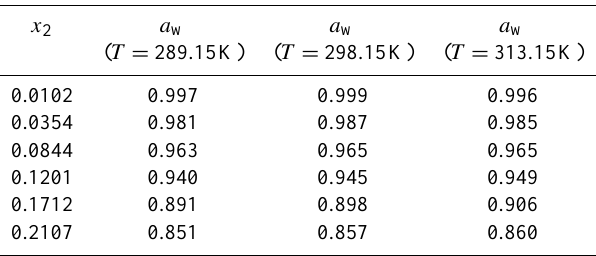
Table A6. Bulk water activity (a w ) measurements a of water (1) + vanillylmandelic acid (2) solutions at three different temperatures. Solution compositions are given in mole fraction of the organic component (2), x 2 . x 2 a w a w a w ( T = 289 .